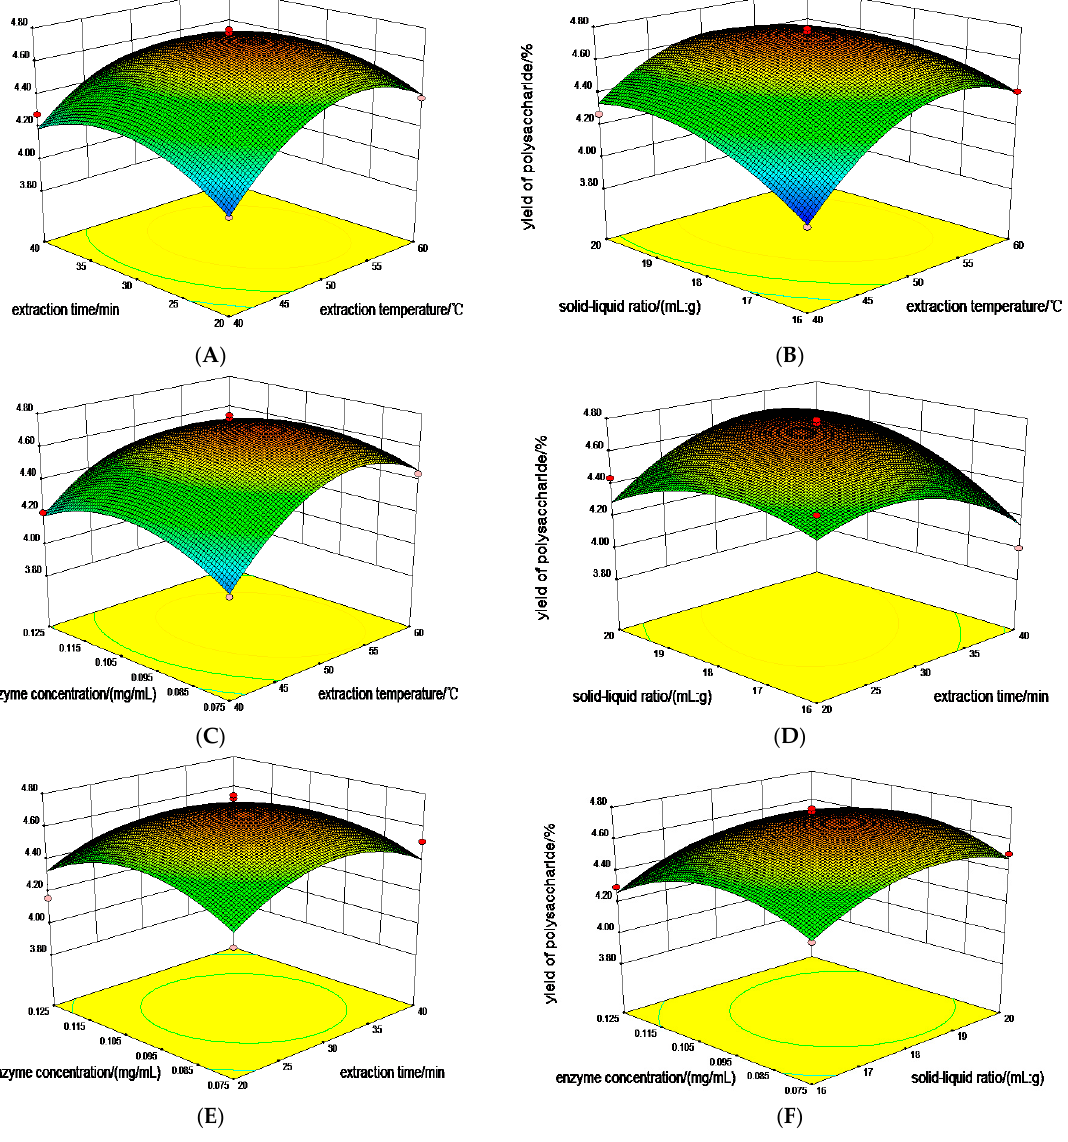
Figure 6. Response–surface plots for processing parameters ( A ) extraction time and temperature, ( B ) solid-liquid ratio and extraction temperature, ( C ) enzyme concentration and extraction temperature, ( D ) solid-liquid ratio and extraction time, ( E ) enzyme concentration and extraction time, and ( F ) enzyme concentration and solid-liquid ratio on polysaccharide yield.